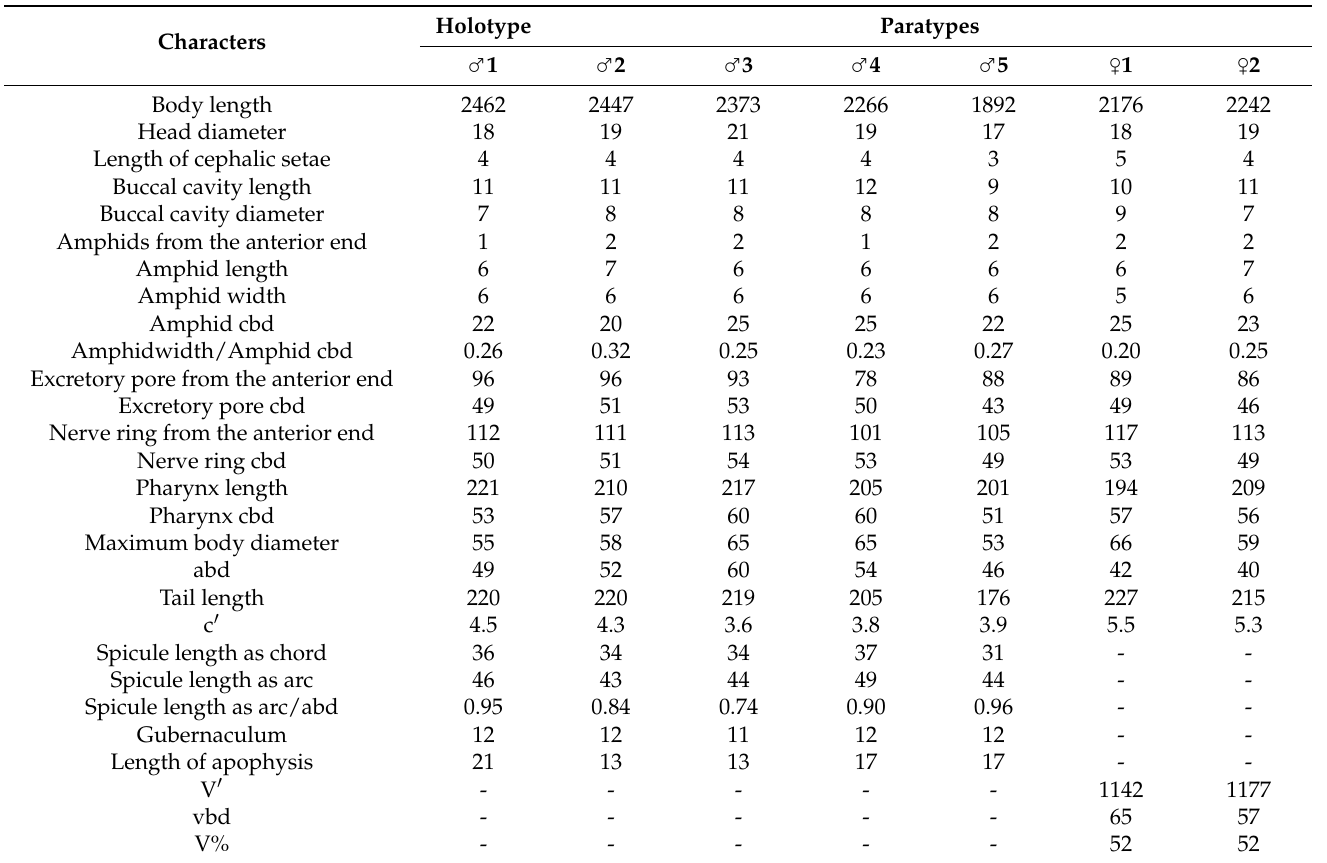
Table 3. Individual measurements of Anticyathus communis sp. nov. (in µ